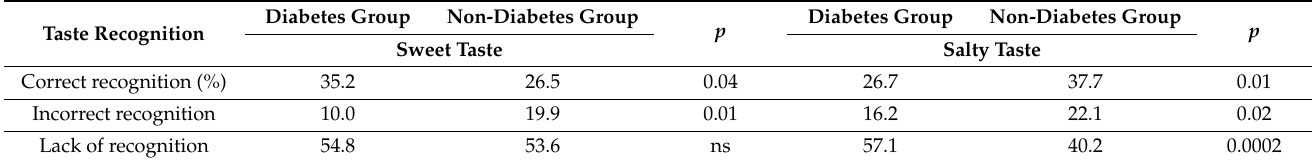
Table 3. The overall evaluation of the recognition of solution